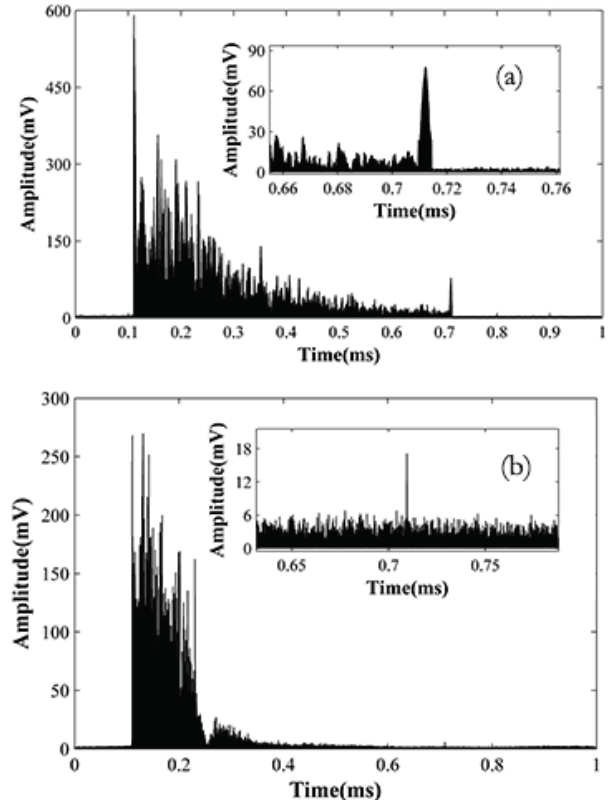
Figure 10. Back scattering traces and their details under 5000 ns ( a ) and 200 ns ( b ) pulse